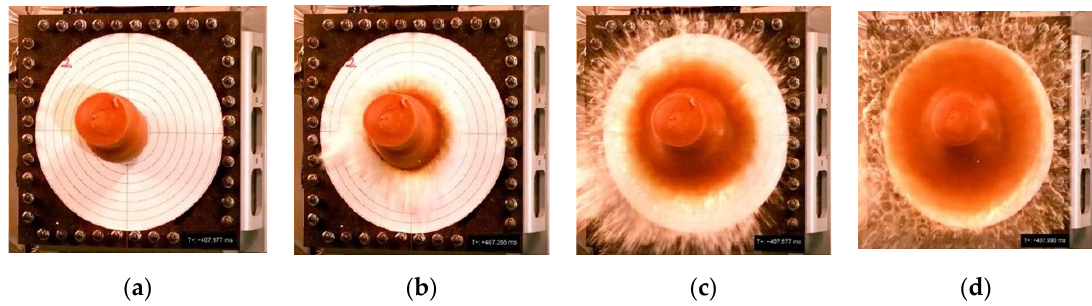
Figure 18. Visualization of the projectile deformation for the impact at 116 m/s: ( a ) 0 ms; ( b ) 0.3 ms; ( c ) 0.8 ms ( d ) 1.2 ms.